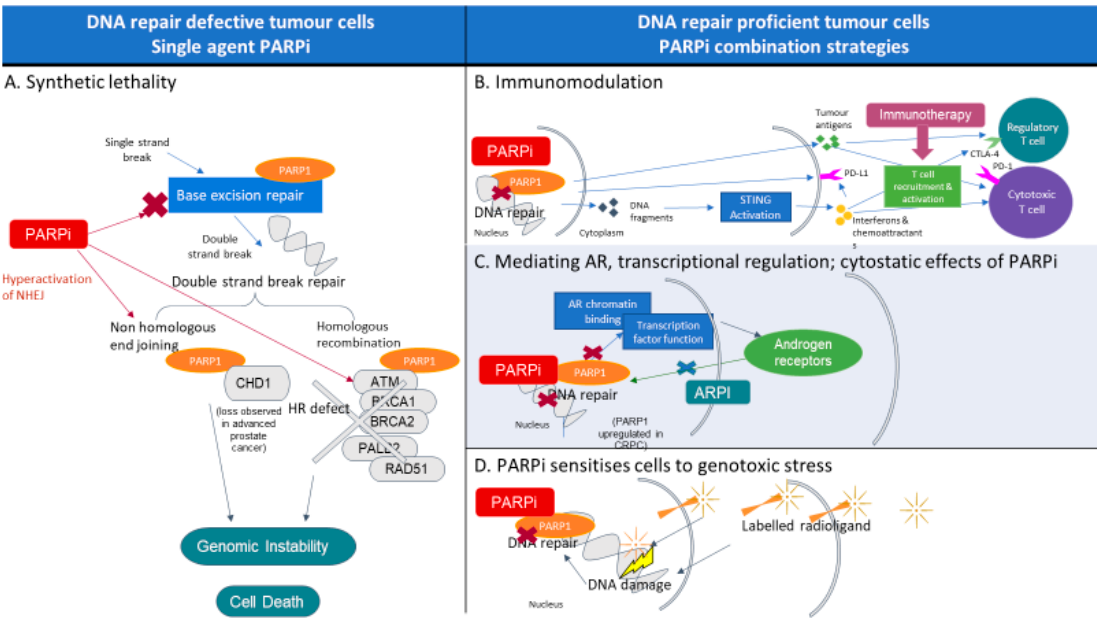
Figure 1. Mechanism of PARPi monotherapy and combination strategies. (HR homologous recombination; STING stimulator of interferon genes; ARPI androgen receptor pathway inhibitors).